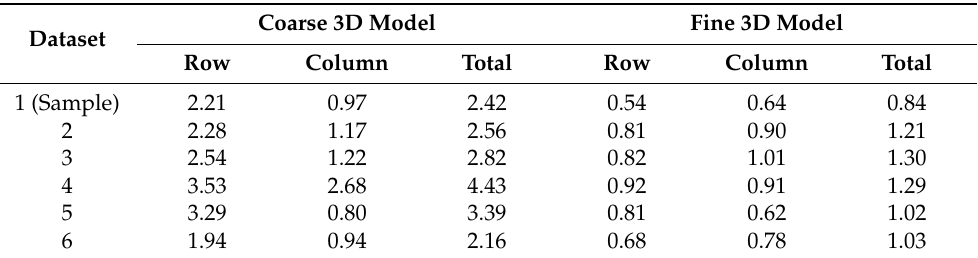
Table 4. RMSEs of the coarse and fine 3D models.